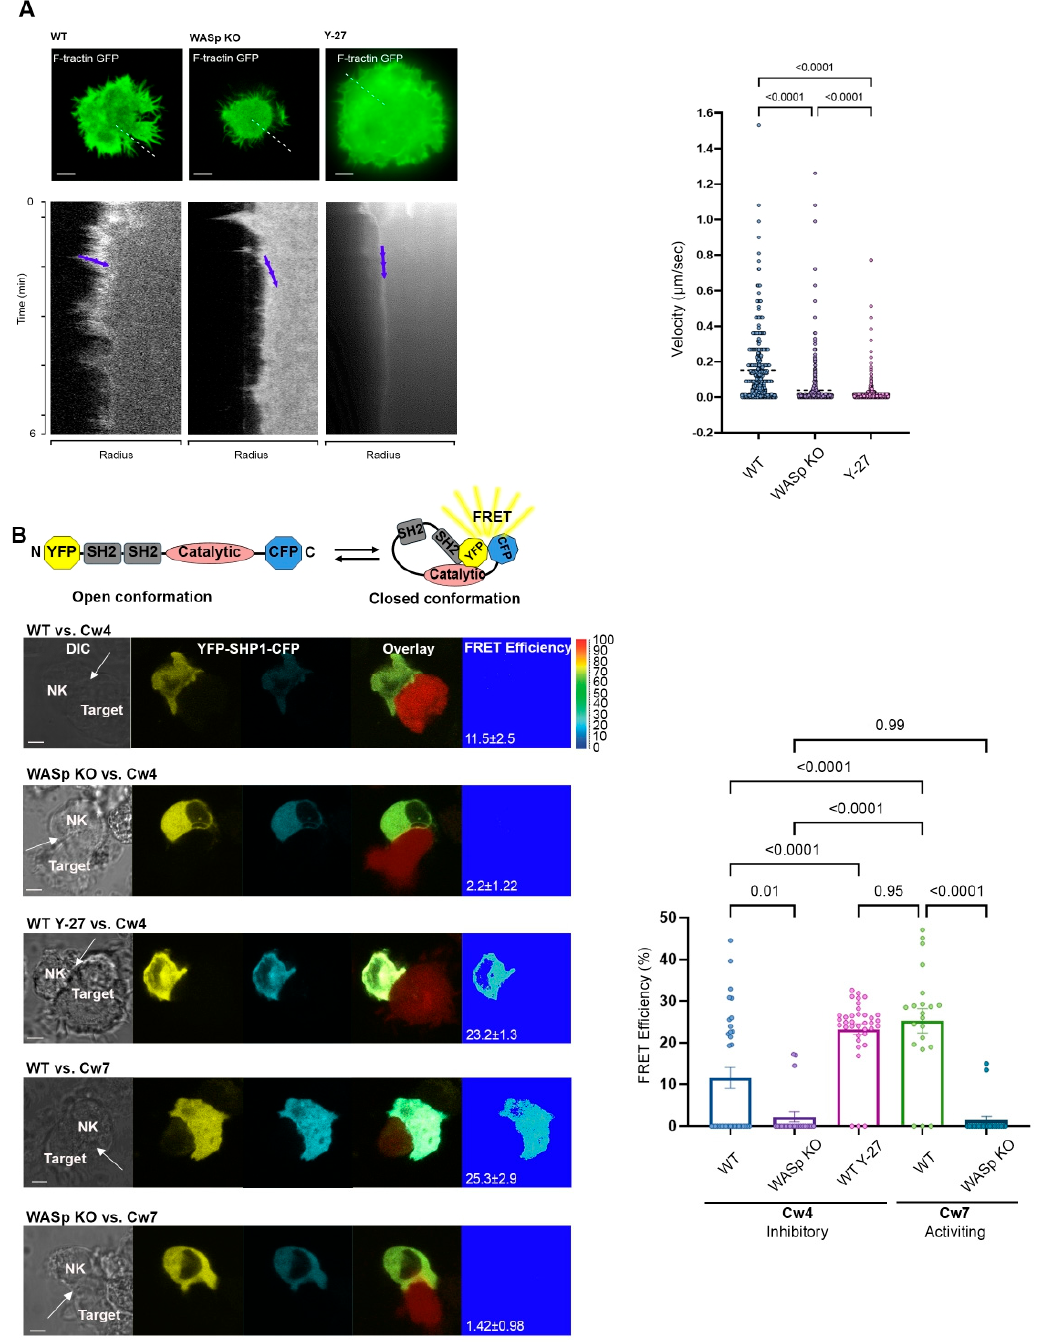
Figure 1. Characterization of F-actin dynamics and SHP-1 conformation. ( A ). Coverslips coated with anti-CD28 were seeded with YTS F-tractin GFP cells and imaged at one frame per second in a single focal plane. Kymographs of F-actin dynamics were compiled along the contact site radius (represented as a white dashed line) and analysis of F-actin traces was compiled into a graph to indicate the F-actin velocity ( μ m/s) at the contact site (YTS/anti-CD28: 12 movies, YTS treated with Y-27/anti-CD28: m 7 movies, WASp KO/anti-CD28: 13 movies). Representative images from movies are shown, and blue arrowheads indicate traces. Scale bars indicate 5 μ m. Data are represented as the mean. Statistical significance was calculated with one way ANOVA test. Movies are provided in the supplementary data. ( B ). Schematic illustration of the YFP-SHP1-CFP FRET sensor. Active “open” SHP-1 conformation results in a large distance between the two fluorescent proteins with no FRET signal. In the inactivated, “closed” SHP-1 conformation, the N- and C-termini are found in close proximity, resulting in high FRET efficiency. YTS-2DL1 cells transiently expressing YFP-SHP1-